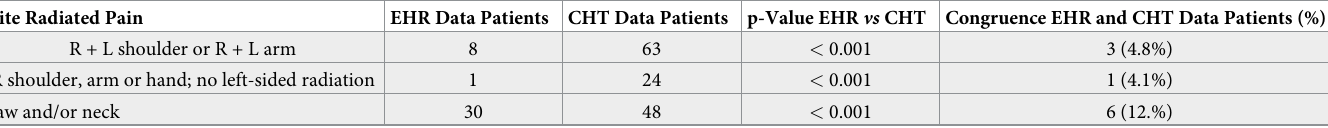
Table 3. Patterns of radiated pain.